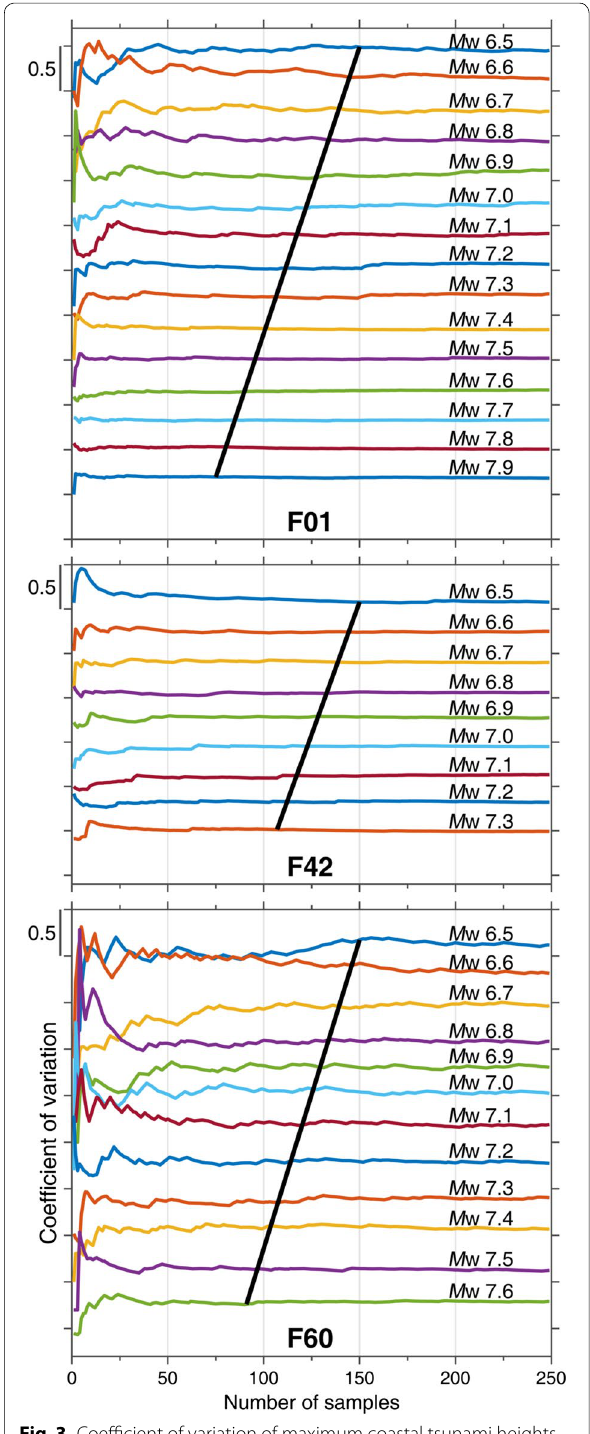
Fig. 3 Coefficient of variation of maximum coastal tsunami heights associated with F01, F42, and F60 faults. The black line indicates the required number of samples at each magnitude bin for the